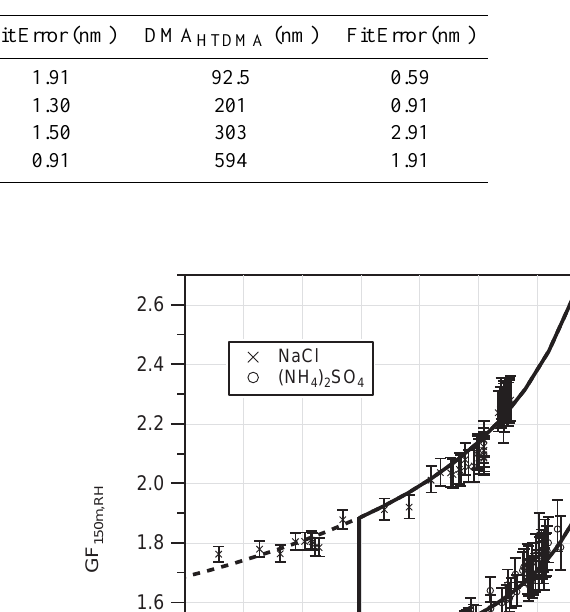
Table 1. DMA PSL calibrations for the DMA supplying the CCNc and the HTDMA’s first DMA. The fit error is the difference between the applied linear fit and the measurement.